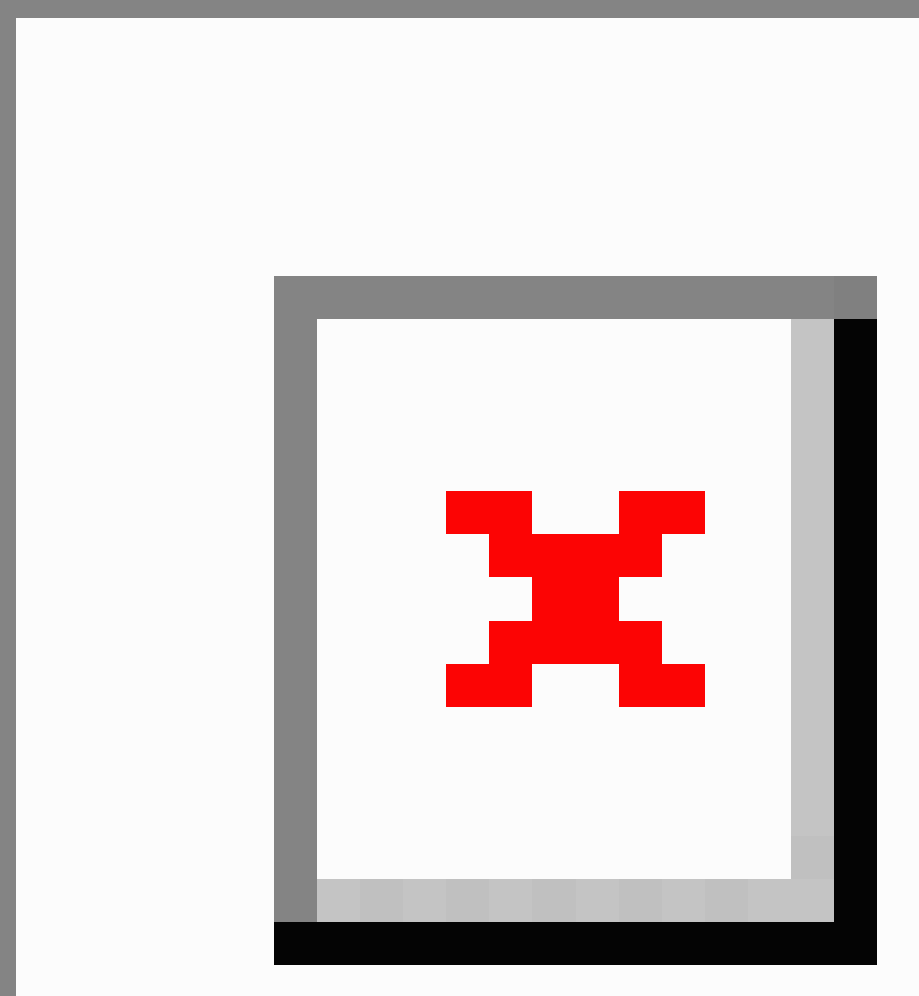
Figure 1. Proportion of invited panels who consented by day and panel